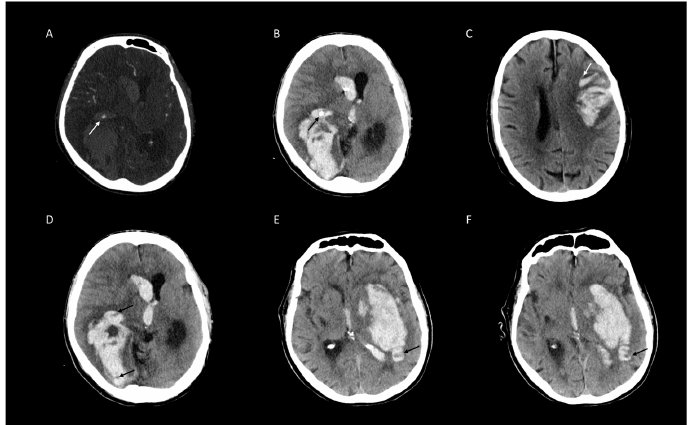
Figure 4. Representative examples of disagreed ratings of four non-contrast computed tomographic (NCCT) markers and Spot Sign (SS) on CT-angiography (CTA) for intracerebral hemorrhage expansion. ( A ) SS on CTA (white arrow) mistaken for intraventricular plexus calcification (black arrow) ( B ). ( C ) Blend sign (white arrows) mistaken for Fluid Sign1. ( D ) Swirl Sign mistaken for Hypodensities (black arrow). ( E ) Hypodensities (black arrow) mistaken for Swirl Sign ( F )